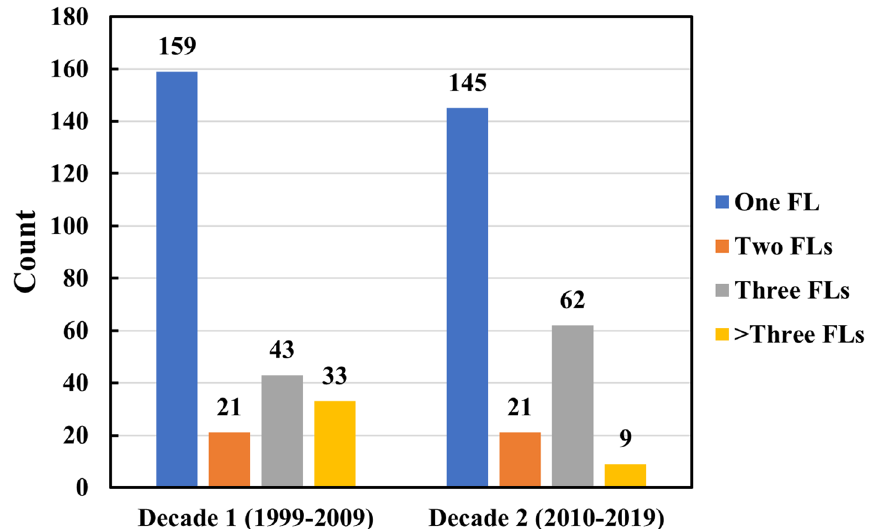
Fig. 11 Comparison between the 1 st and 2 nd decade regarding the number of hepatic focal lesions Fig. 2. This chart showed that, there is no significant difference in 1and 2 FHL between two decades, 3 focal lesions were more in 2 nd decade while > 3 FHL were more in 1 st decade which is statistically signficant